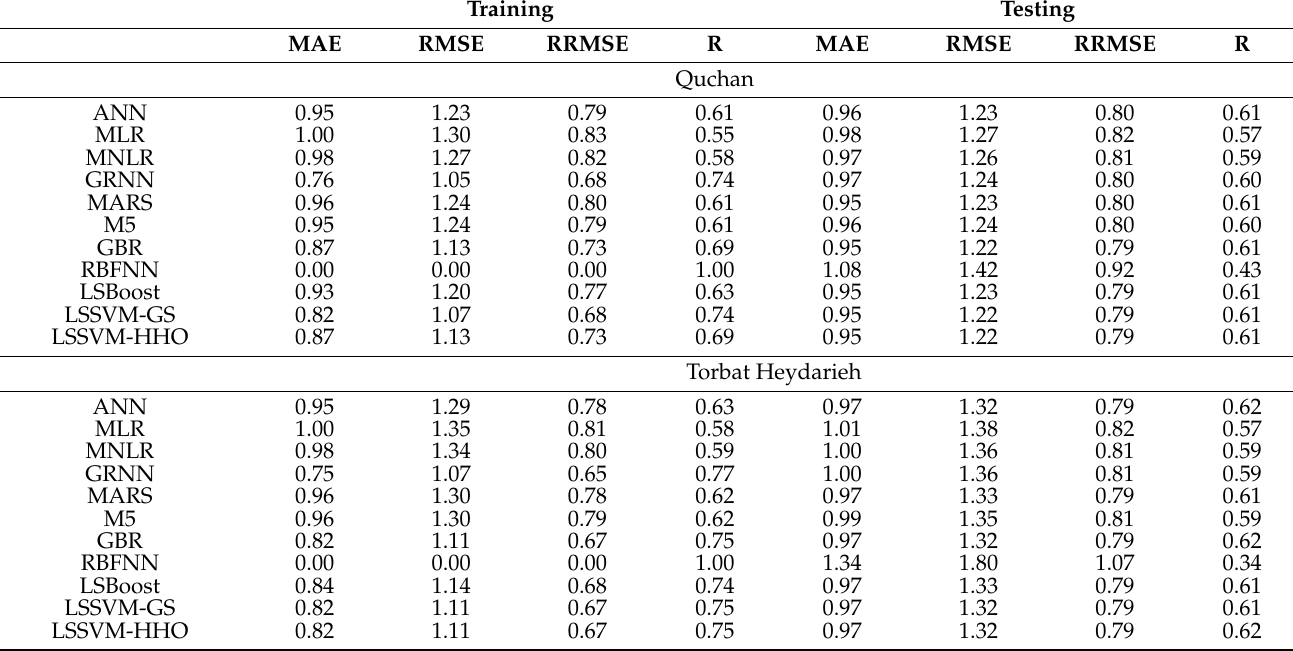
Table 2. Results of modeling WS with the base algorithms at the different stations. Training